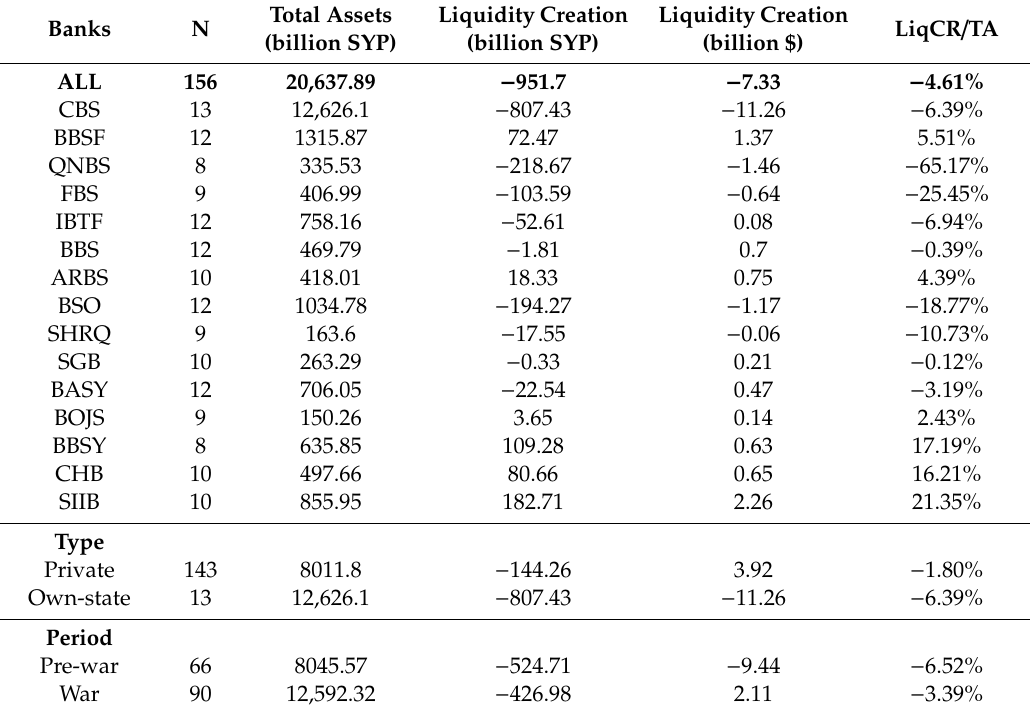
Table 4. Liquidity creation of Syrian commercial